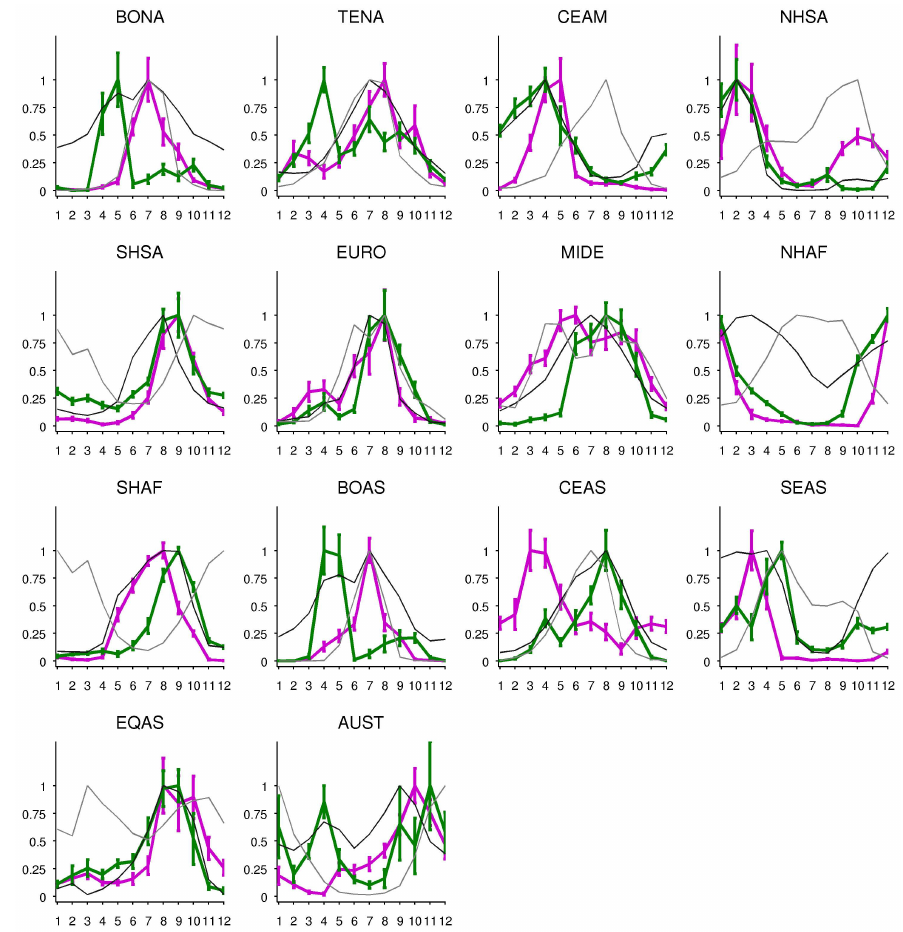
Fig. 3. Agricultural ( F a , green) and non-agricultural ( F n , purple) fire seasonality derived from GFED for the regions in Fig. 1. The x-axis shows months and the y-axis shows F a and F n normalized to the maximum. The error bars indicate the interannual variability in F a and F n from 2000–2009. The dark gray line is the normalized flammability index, and the lighter gray line is the normalized lightning